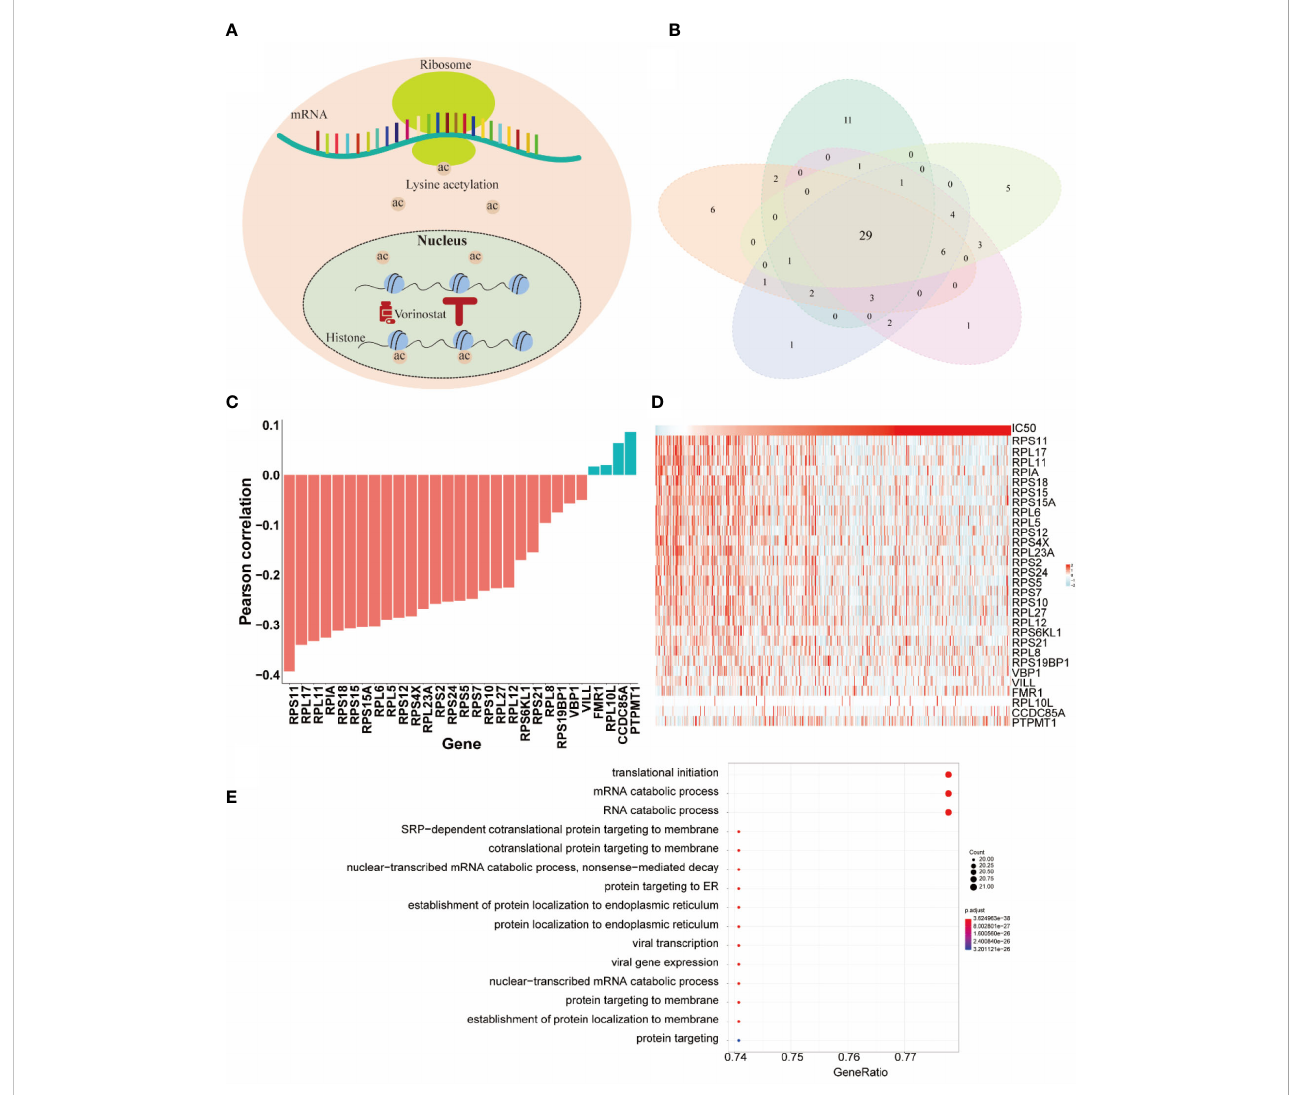
FIGURE 5 The HiRAND interpretation to identify predictive markers. (A) Schematic representation of acetylation sites. (B) The intersections of genes across fi ve repeat experiments were treated as the predictive markers. (C) The Pearson correlation between the 29 predictive markers and IC50 value. (D) The heatmap of the gene expression of the 29 predictive markers. (E) GO analysis results of the 29 predictive